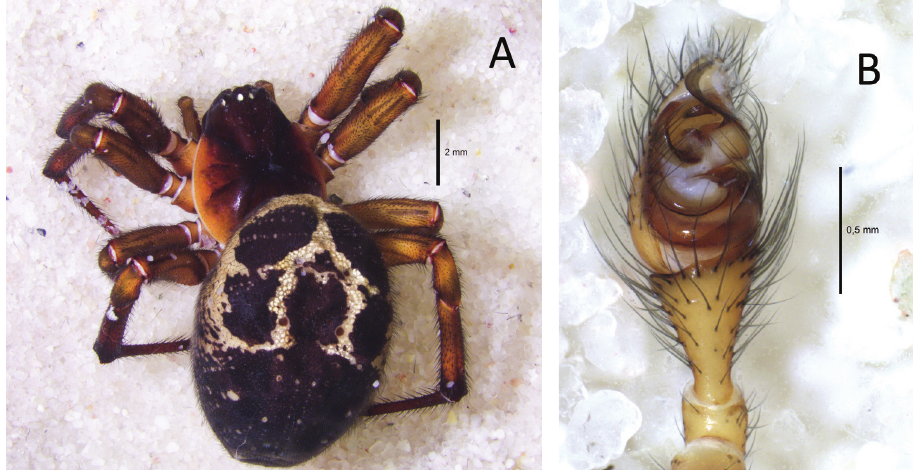
Figure 5. Habitus and male genitalia of Steatoda nobilis . A Female from Normandy, France B Male pedipalp in ventral view from Stuttgart, Germany.